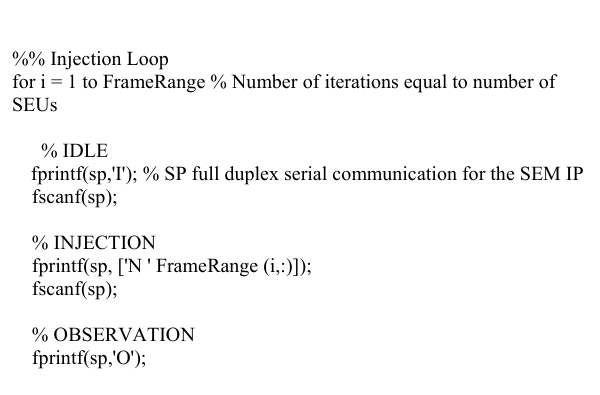
21 of 24 Figure 25. Interface ACME tool. ACME computes these inputs generating as a result, a text file named FrameRange. It collects a subset of essential bits belonging to the pBlock area. For instance, in the above Figure 9974 essential bits are identified from the .ebd file. These bits are translated by ACME into configuration memory addresses that will be used by the SEM IP controller to conduct one injection per address, in the following way: N {10-digit hex value}: N C00XXXXXXX As it can be noticed, this routine is composed of the N injection command and the address translated by ACME that corresponds with an essential bit belonging to the pBlock. More details about ACME tool, can be found in the web site of the ARIES research group [46].